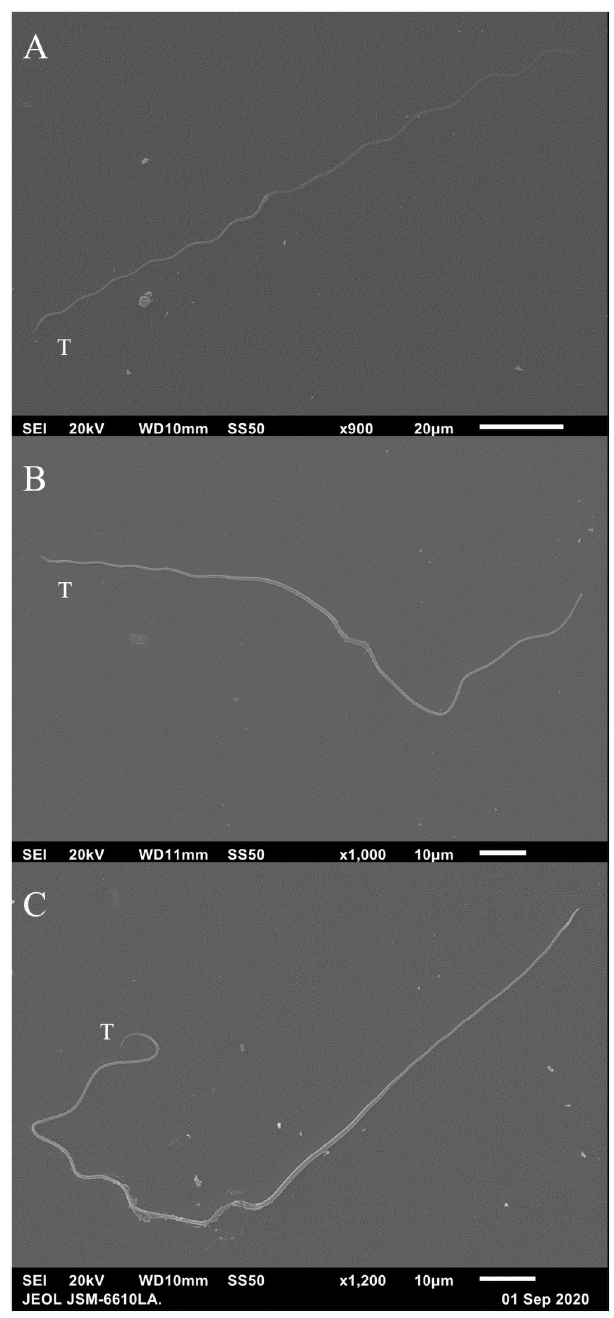
Fig 5. Tuatara ( Sphenodon punctatus ) sperm visualized using SEM. Photographs (A–C) of whole Sphenodon punctatus sperm captured using scanning electron microscopy. Sperm had been previously treated with Lake’s solution and flash frozen, before being thawed and photographed. Note the scale difference on the first image. T = tail end.